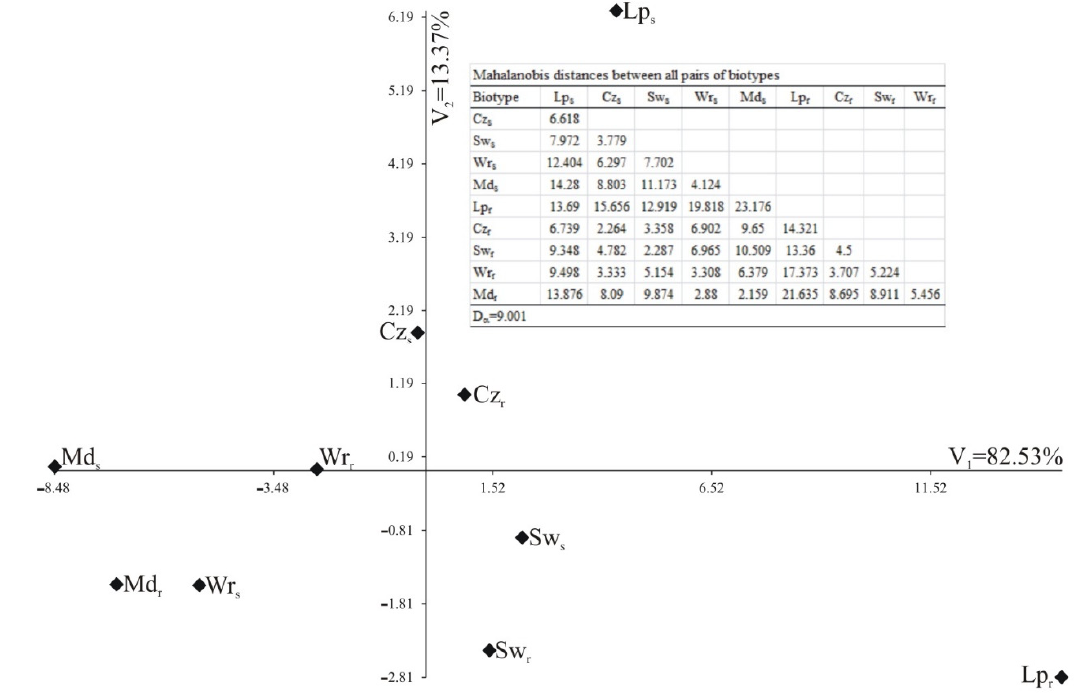
Figure 11. Distribution of combinations of sites and herbicide-resistance (R)/susceptibility (S), based on parameters of winter wheat (WW), in the space of the first two canonical variables (V 1 and V 2 ), in 2018–2019. Sites: Cz—Czesławice, Md—Mydlniki, Lp—Lipnik, Sw—Swojczyce, Wr—Wrocław. Subscript “r” denotes the competition of WW with R and the subscript “s” with S.